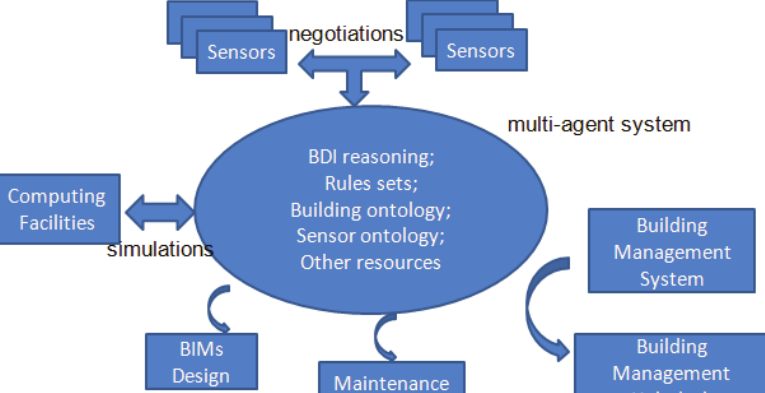
Fig. 1. Multi layered system